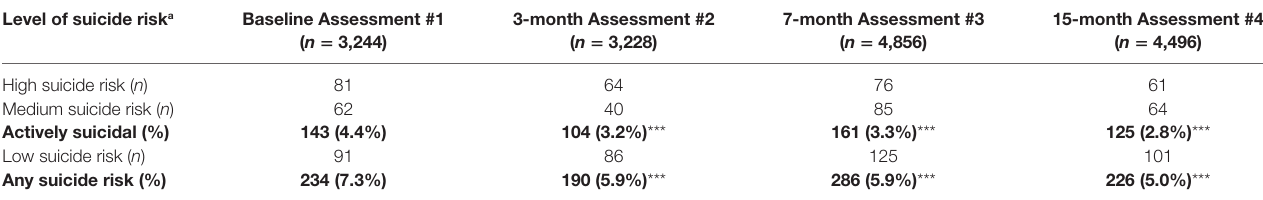
TaBle 3 | changes in suicidality for entire study population.